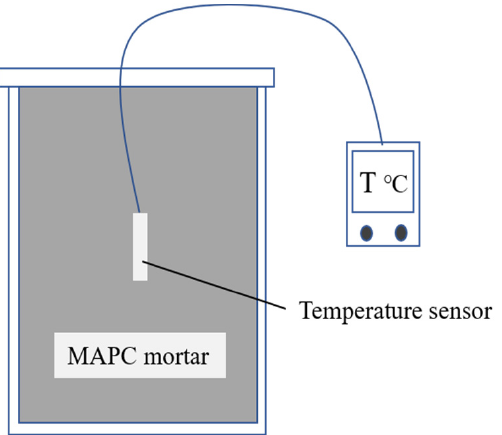
Figure 2. Testing apparatus of hydration temperature of MAPC during early age at 24 h.